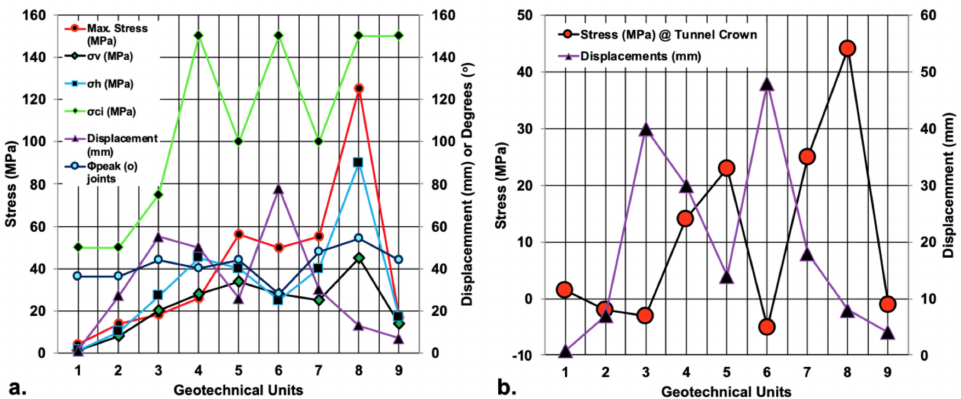
Figure 16. ( a ) Maximum stress and displacements per tunnel domain in relation with σ ci and ϕ peak and ( b ) stress and displacements on tunnel crest.